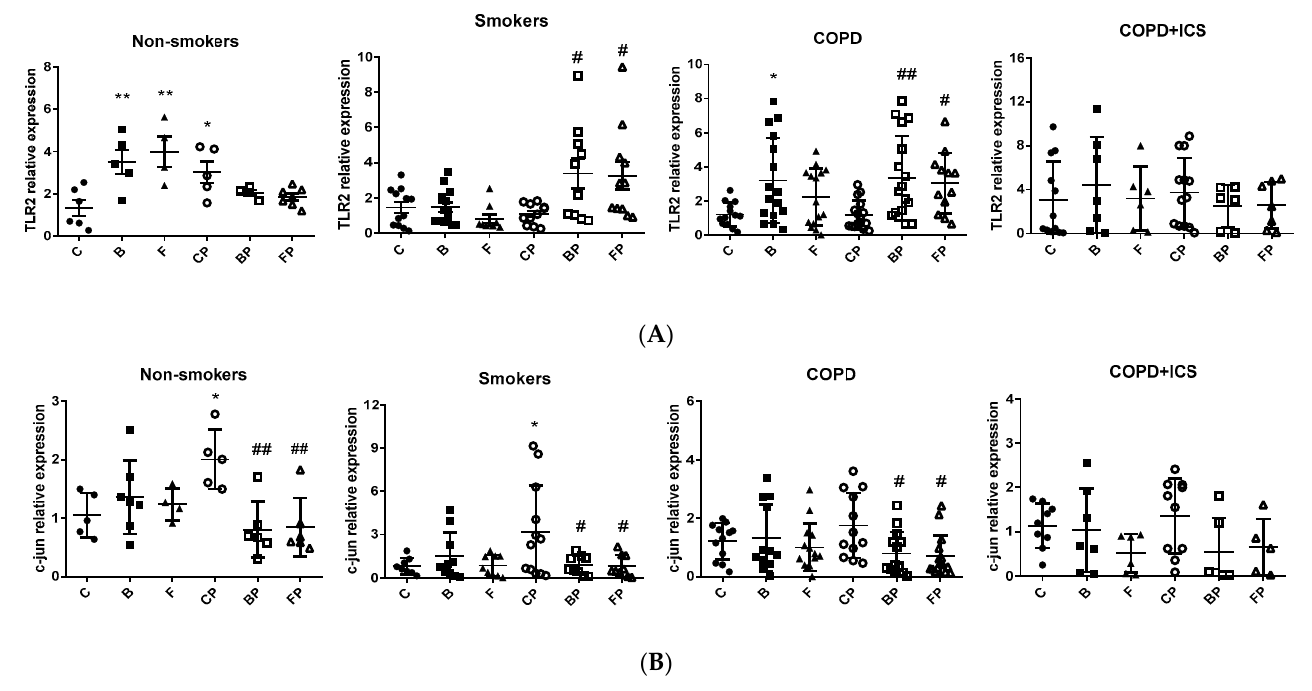
Figure 2. TLR2 ( A ) and c-jun ( B ) mRNA expression in alveolar macrophages from nonsmokers, smokers, COPD, and COPD patients under corticoid treatment (COPD + ICS): C, control; B, stimulated with BUD; F, stimulated with FLU; CP, stimulated with Pseudomonas aeruginosa ; BP, stimulated with Pseudomonas aeruginosa and BUD; FP, stimulated with Pseudomonas aeruginosa and FLU. One-way ANOVA, Bonferroni’s post hoc; * p < 0.05 vs. C; ** p < 0.01 vs. C; # p < 0.05 and ## p < 0.01 vs. CP. C: ● ; B: ■ ; F: ▲ ; CP: ○ ; BP: □ ; FP: Δ .